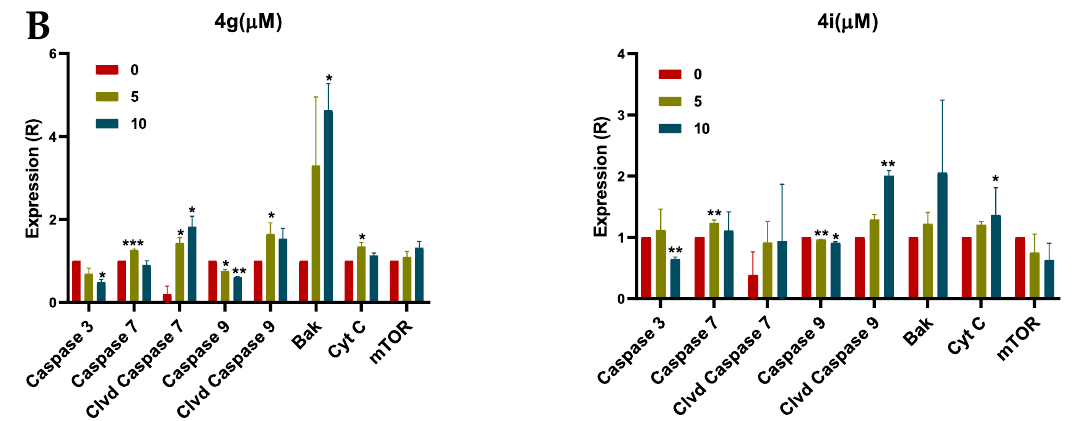
Figure 4. The effect on apoptosis induction at different concentrations of 4g and 4i in MDA-MB-231 cells. ( A ) Western blots for the proteins caspase 3, caspase 7, cleaved caspase 7, caspase 9, cleaved caspase 9, Bak, cyt C and mTOR following incubation with 4g and 4i at 0, 5, or 10 µM. The values of the proteins were normalized to β -actin levels. ( B ) Histograms summarizing the levels of each protein are also shown. All the data are presented as the means ± SEM of three independent studies with * p < 0.05, ** p < 0.01, *** p < 0.001 vs. control group. Cleaved is abbreviated as Clvd.